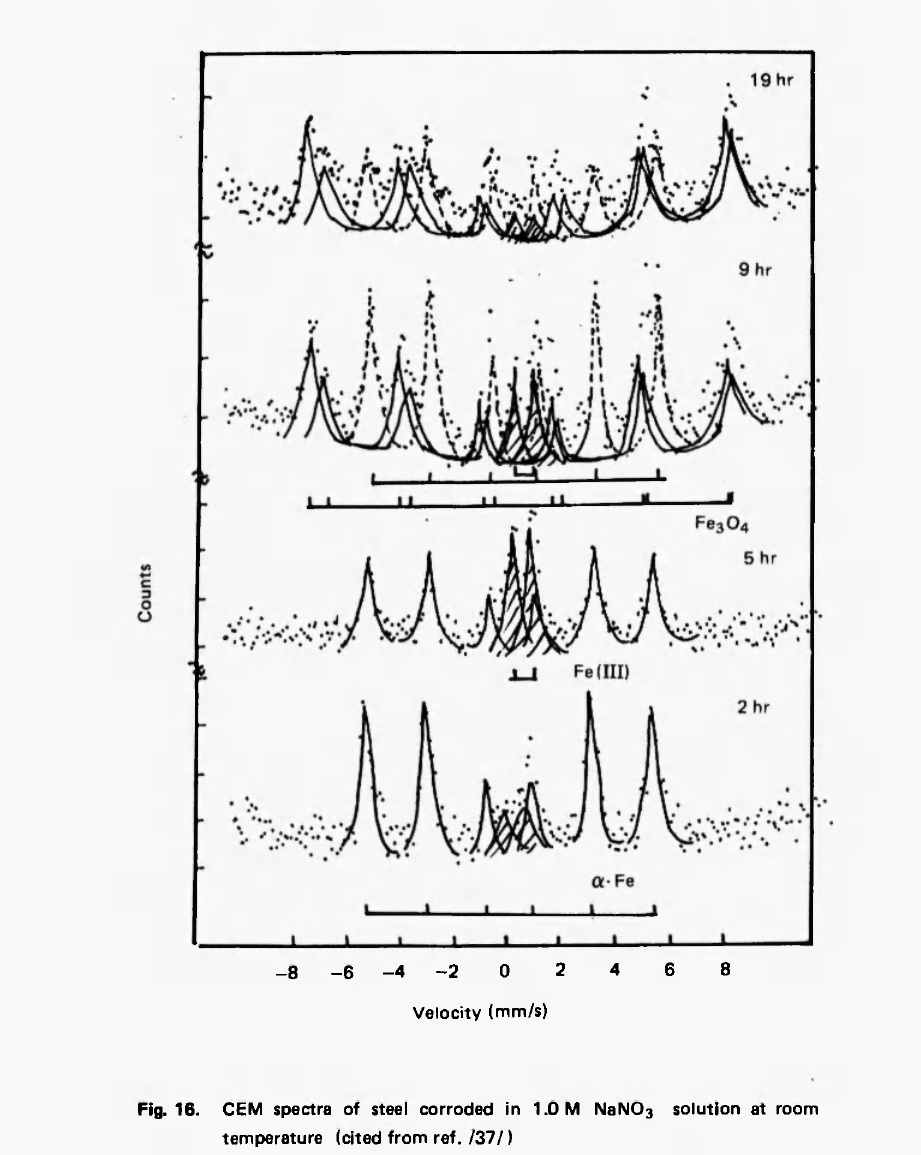
Fig. 16. CEM spectra of steel corroded in 1.0 Μ NaNC>3 solution at room temperature (cited from ref.